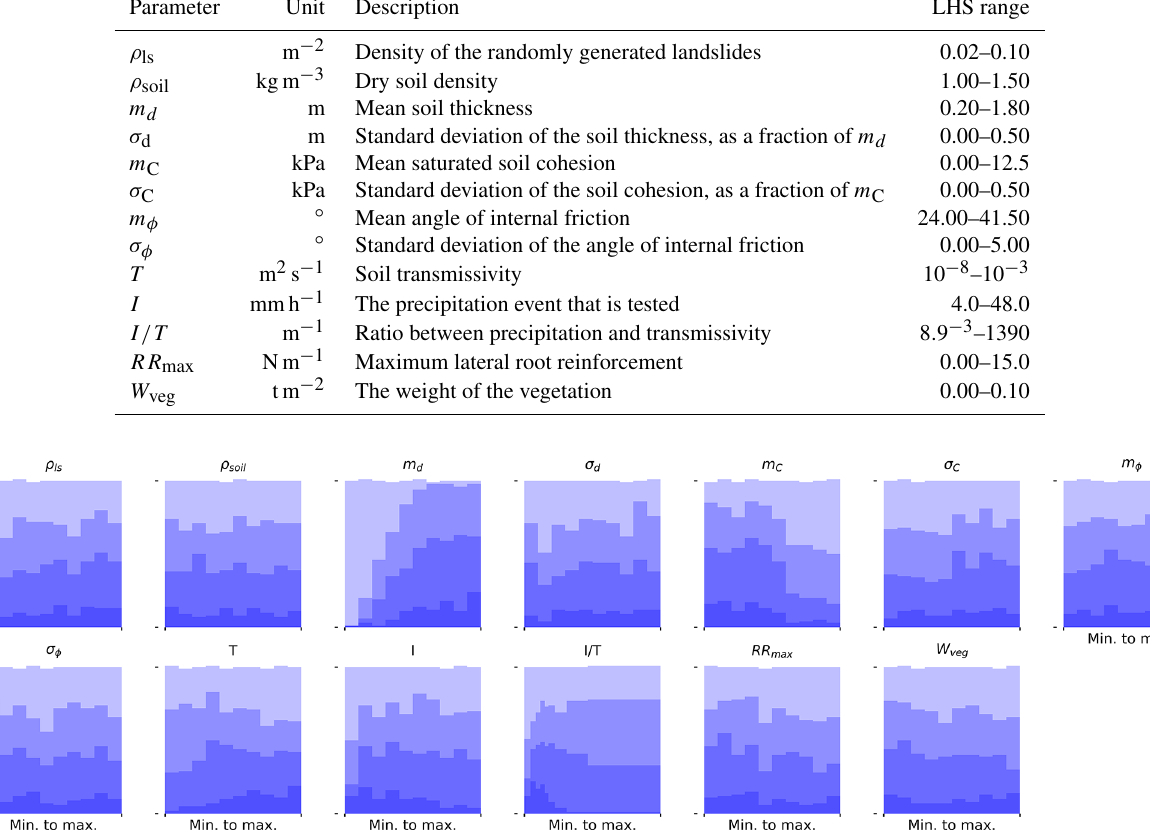
Figure 5. Histograms of different subsamples of the LHS parameter sets for the Trub study area. The shading (from light to dark) corresponds to subsamples retaining only the x % highest parameter sets in terms of the AUC; the fractions shown are as follows: 1, 0.7, 0.4 and